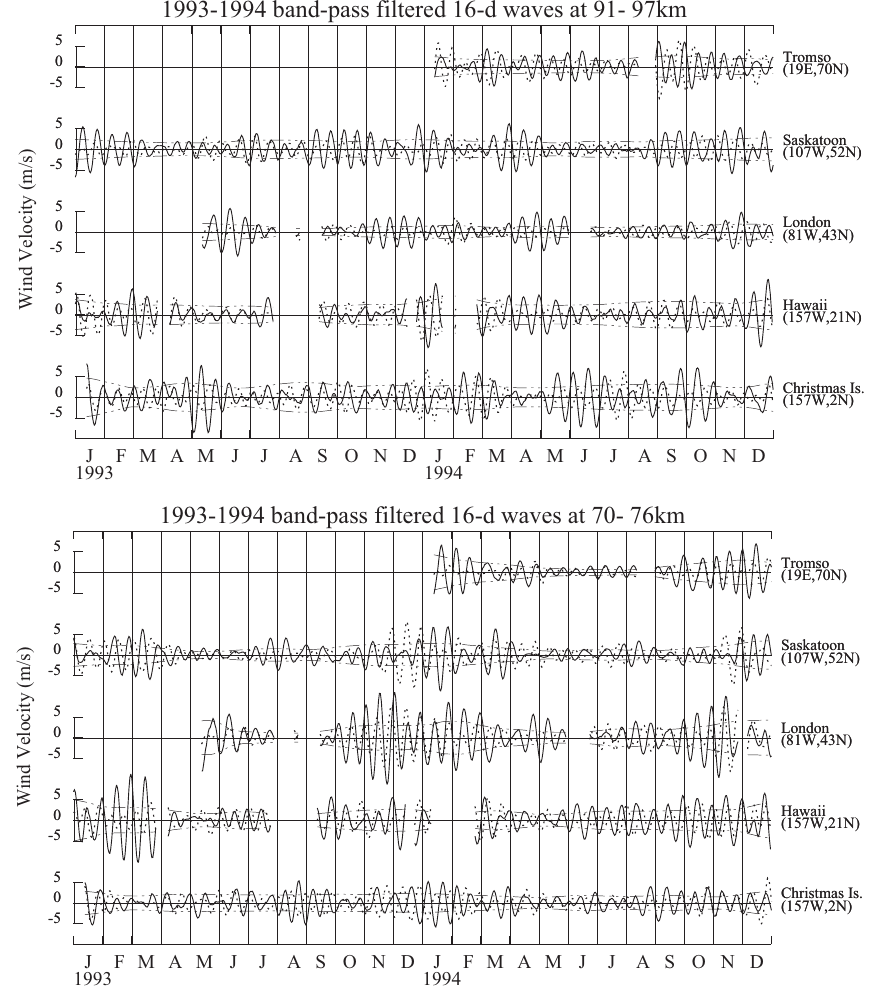
Fig. 4. The filtered winds of 16-day waves at five locations during 1993–1994, and at two layers of 70–76 and 91–97km. The filter is an FIR type with the kernel length of 64 days. The solid lines are for the zonal winds, and the dashed for the meridional winds. The envelope-like curves are the 95% confidence levels for the filtered wave in the zonal winds (levels for meridional ones not